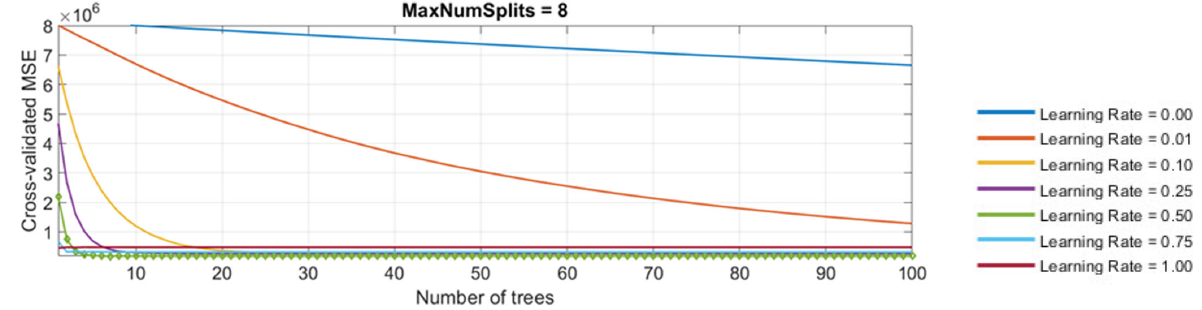
Figure 11. The influence of the parameters of the boosted trees model on the value of the MSE cri ‐ terion.